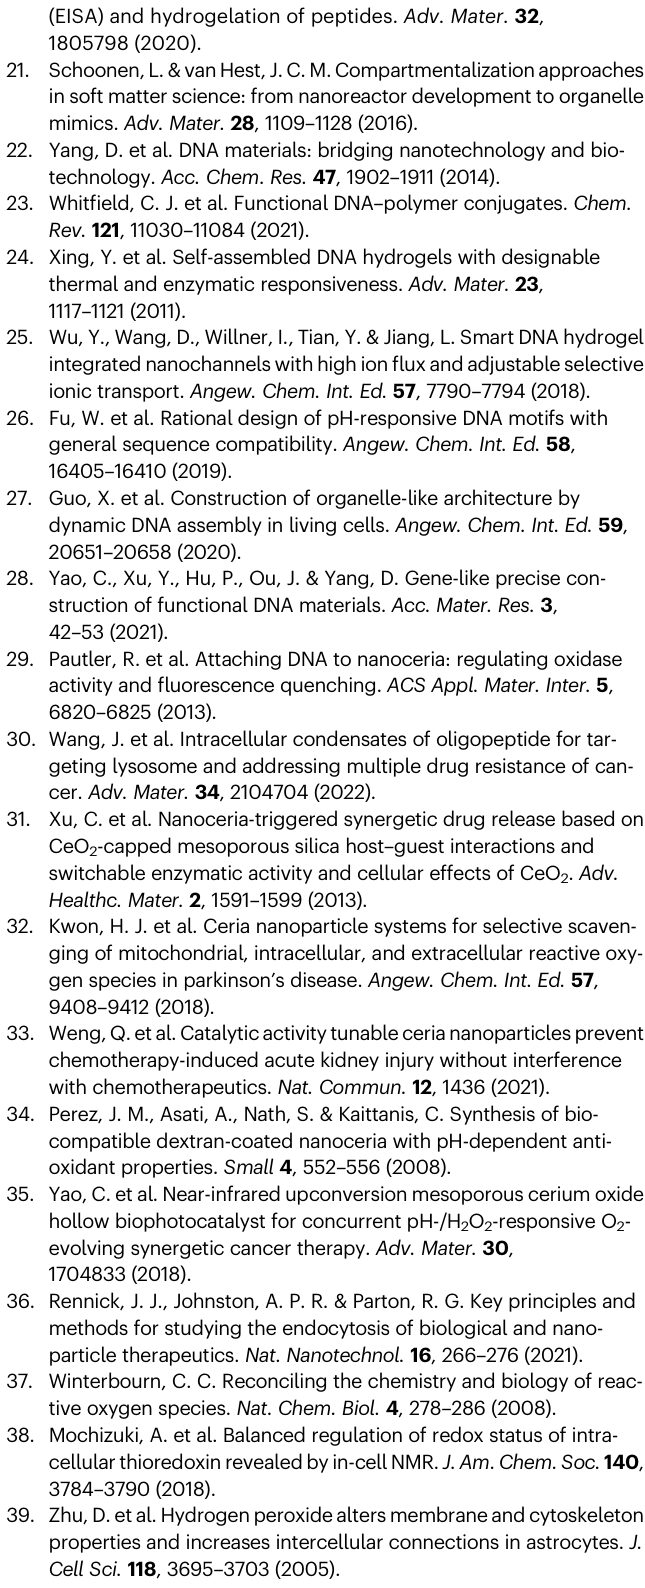
Figure treatment Microsoft PowerPoint 2019 was used to organize fi gures. ImageJ Fiji v1.52v was used to process microscopy